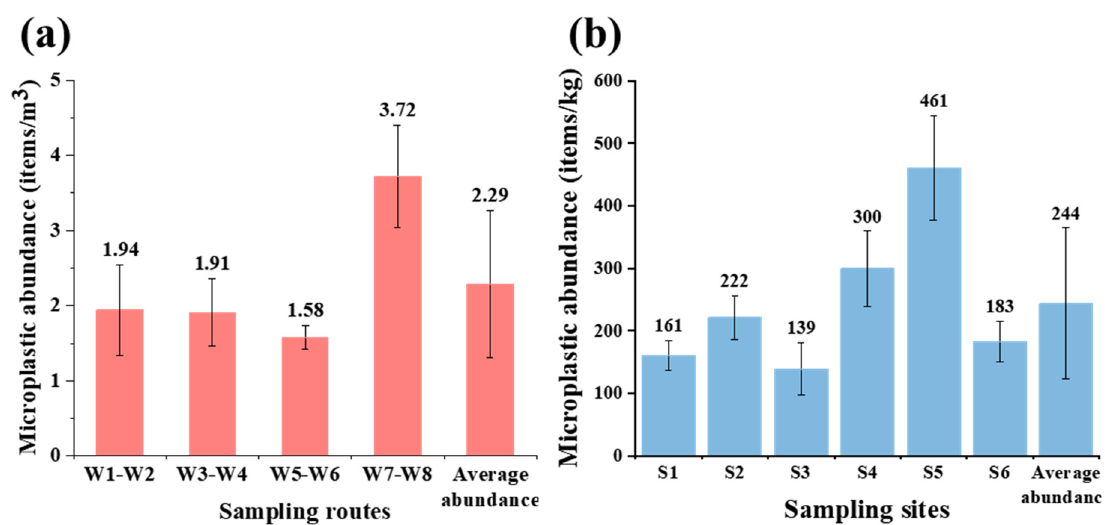
Figure 3. The abundance of microplastics collected from the surface water ( a ) and the surface sediments ( b ) of Songshan Lake. Table 3. Comparison of microplastic abundance in freshwater lake studies around the world. Avg. means the average abundance of microplastics.